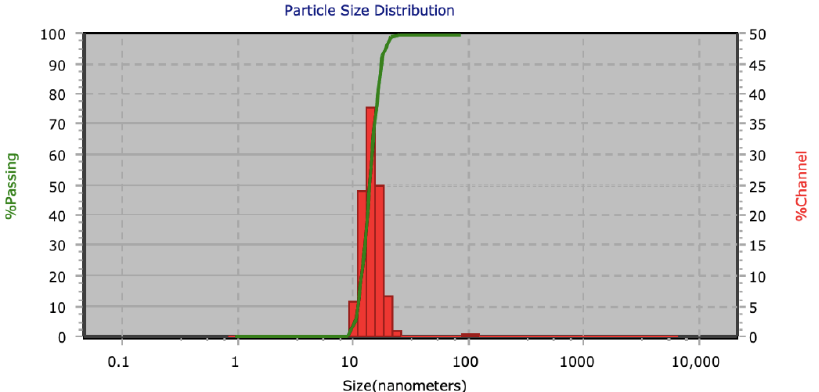
Figure 2. Size distribution of AuNPs obtained by DLS analysis.